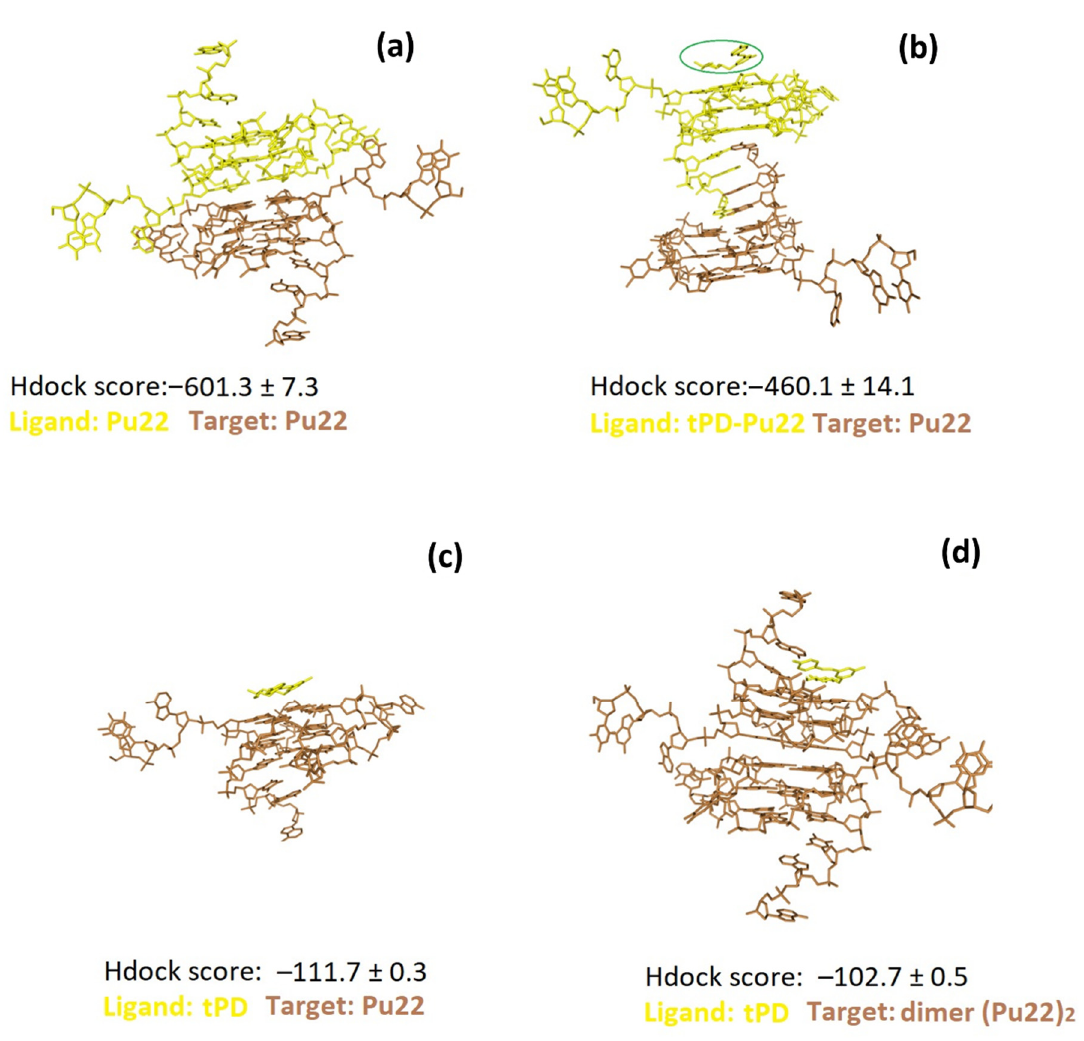
Figure 4. Docking of Pu22 ( a ) or tPD-Pu22 ( b ) to another Pu22 unit. Docking of tPD to Pu22 monomer ( c ) or dimer ( d ). Hdock scores (mean of top-1–3 values) were also indicated. Remarkably, the dimeric form of Pu22 G4 with tPD (Figures 4b and 5a) was predicted to show considerable structural differences with respect to the unliganded (Pu22) 2 G4 dimer (Figure 4a). In this regard, it is worth noting how 18 hydrophobic/ π – π stacking Pu22-Pu22 intermolecular interactions (pink, Figure 5b) along with six intermolecular H-bonds (green) are predicted to sustain the trimeric complex structure.